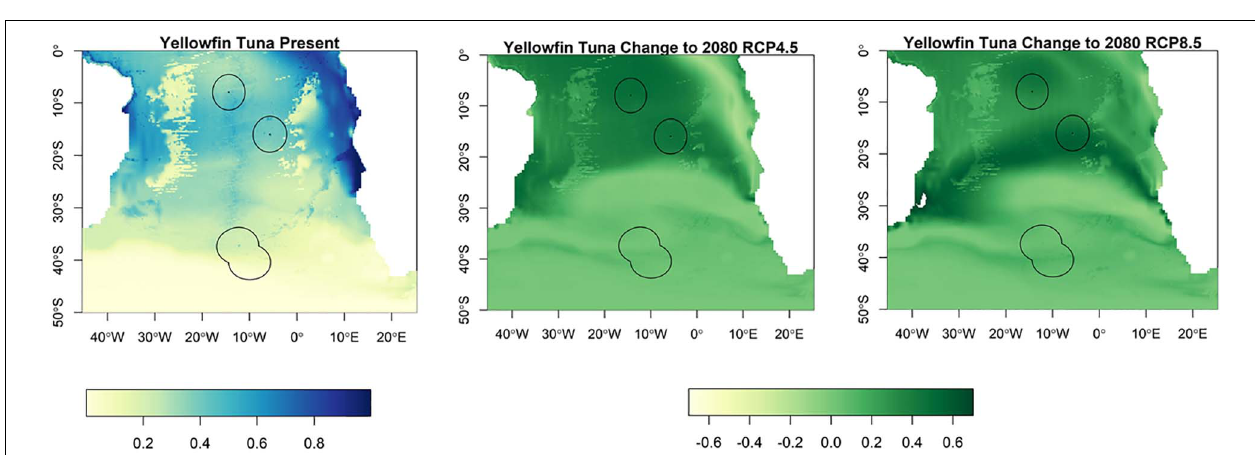
FIGURE 4 | The habitat suitability for bigeye tuna from Maxent in the South Atlantic for the present day and the change to 2080 under RCP4.5 and RCP8.5. The EEZs are shown in the black outline. The yellow areas are the most suitable, and the dark blue the least suitable.